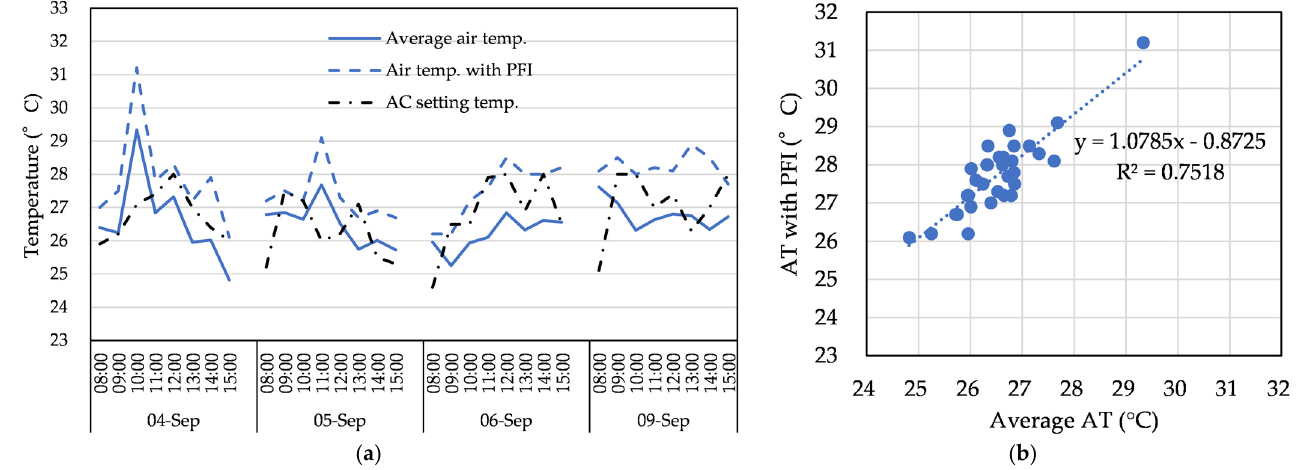
Figure 21. Summer indoor air temperature and correlation for the ( a ) summer average AT, AT with PFI, AC setting temp. of class A and ( b ) summer AT, AT with PFI correlation of class B.